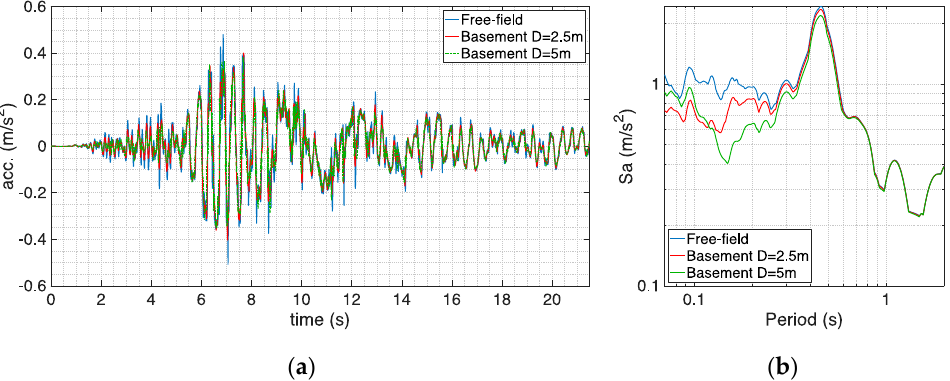
Figure 13. Comparison between surface free-field motion and signals at basement level (two different depths) for nonlinear academic soil profile and record “Accel outcrop” in terms of acceleration ( a ) histories and ( b ) response spectra.